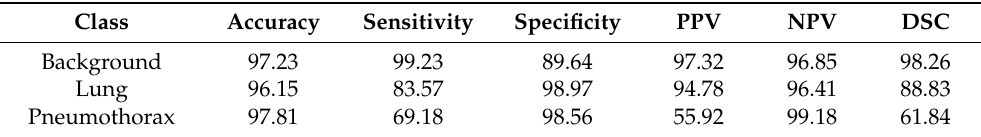
Table 2. Results of deep-learning-based automatic region-segmentation